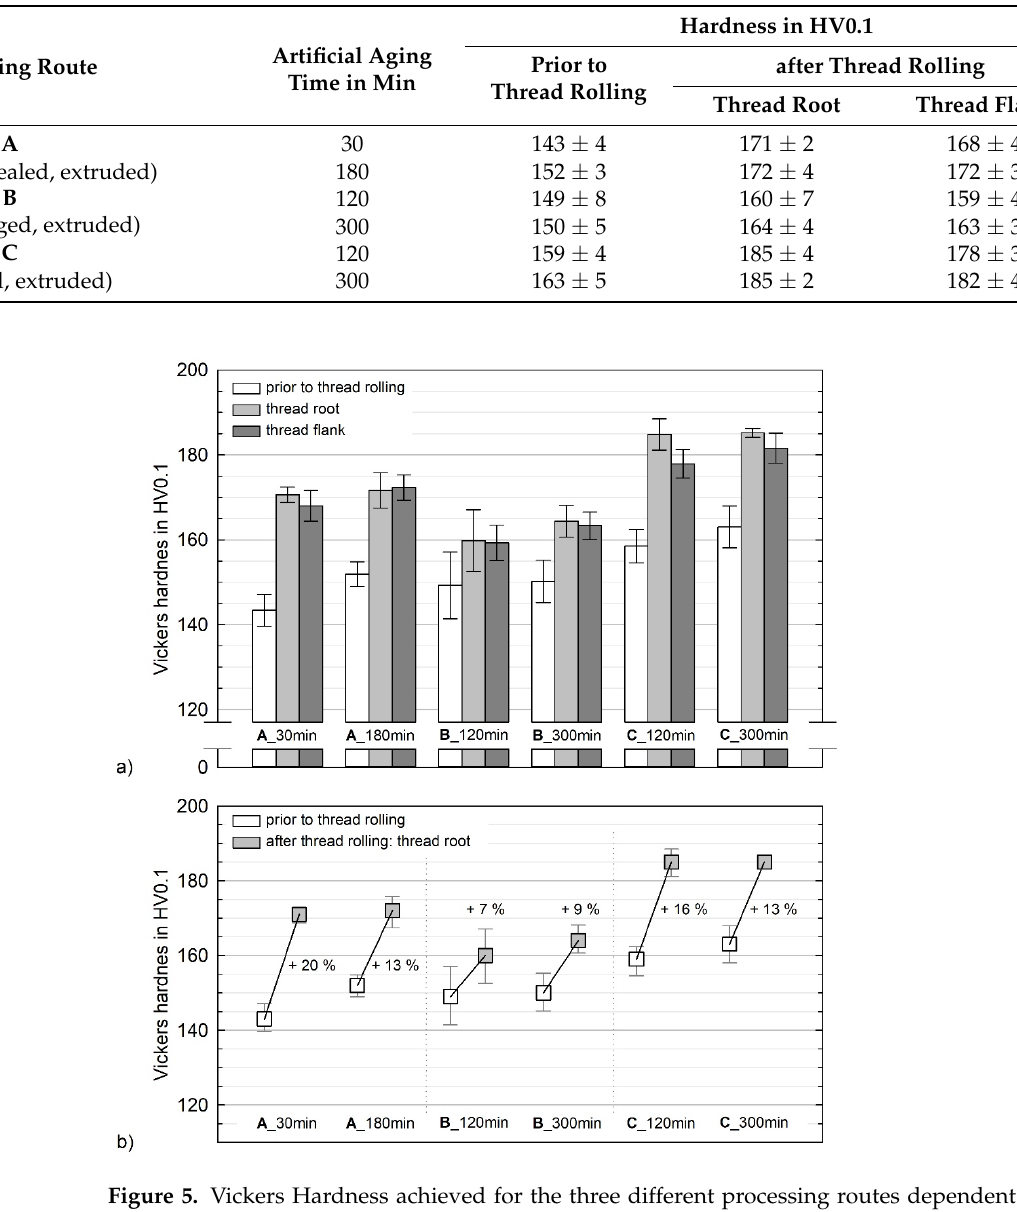
Table 3. Vickers hardness of different stages along the investigated processing routes of the aluminum wire alloy 6056.